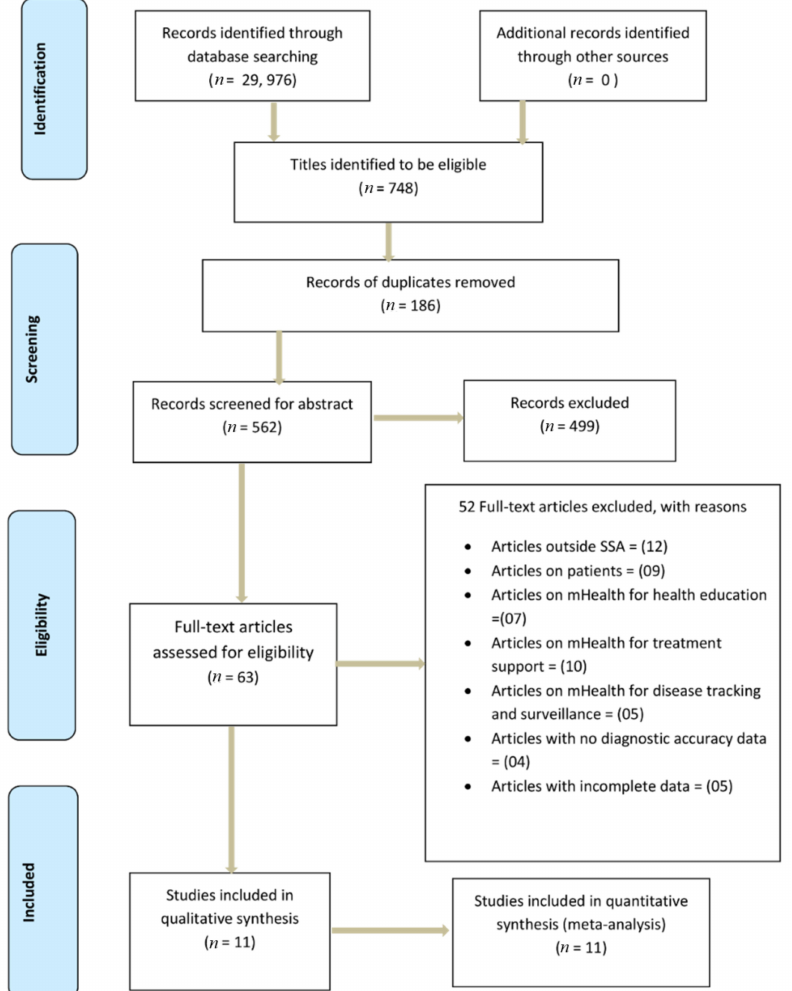
Figure 1. PRISMA flow chart showing literature search and selection of